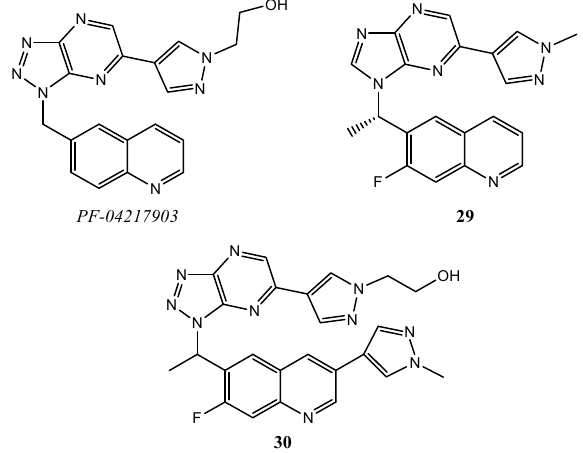
Figure 10. Structures of some hybrid quinoline derivatives as c-Met inhibitors.